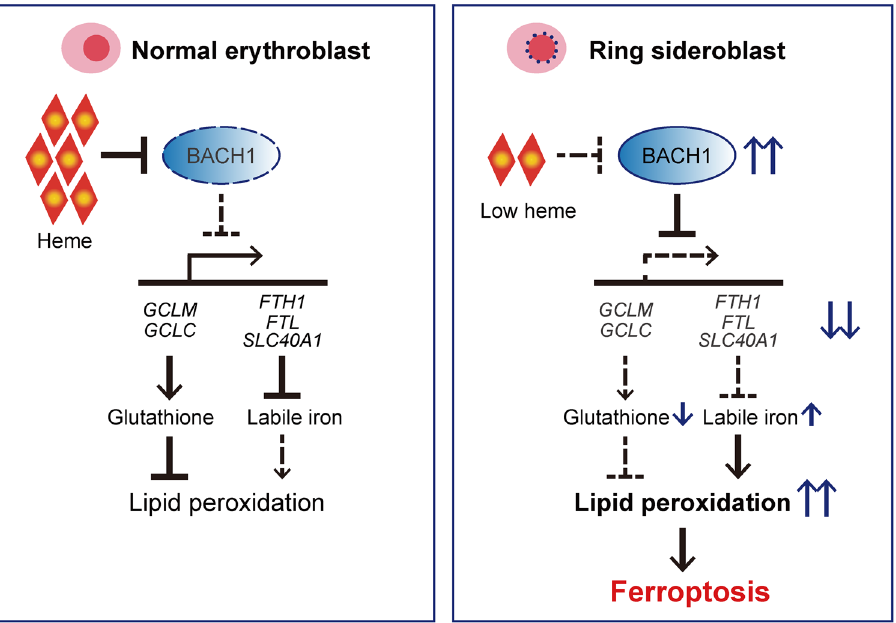
Figure 7. Schematic representation of the pathophysiology of XLSA. In XLSA, impaired heme biosynthesis enhances BACH1 expression, resulting in the alteration of the transcriptional program during differentiation, resulting in the suppression of genes associated with glutathione synthesis (i.e., GCLM ) and iron metabolism (i.e., FTH1 and FTL ). Reduced glutathione synthesis causes higher levels of lipid peroxidation, leading to increased ferroptosis